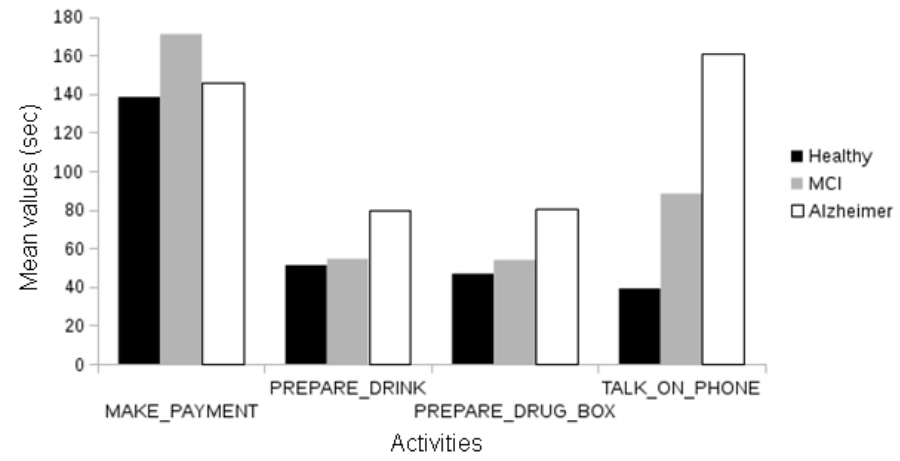
Figure 9. Comparison between the duration of automatically recognized events of the different cognitive status groups of the Nice pilot.